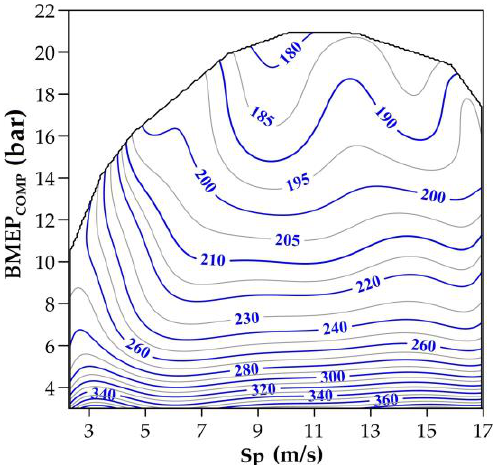
Figure 13. Brake-specific fuel consumption map (g/kWh) of the realistic compound engine, as a function of the overall load and mean piston speed.